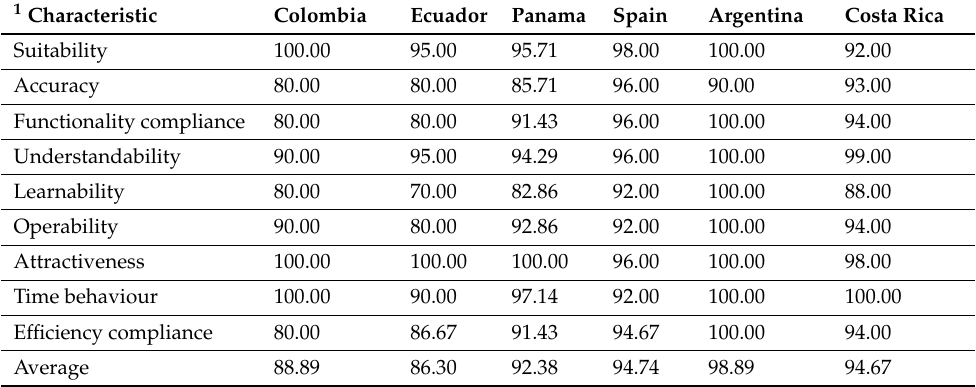
Table 4. Synthesis of the evaluation matrix according to the judge’s